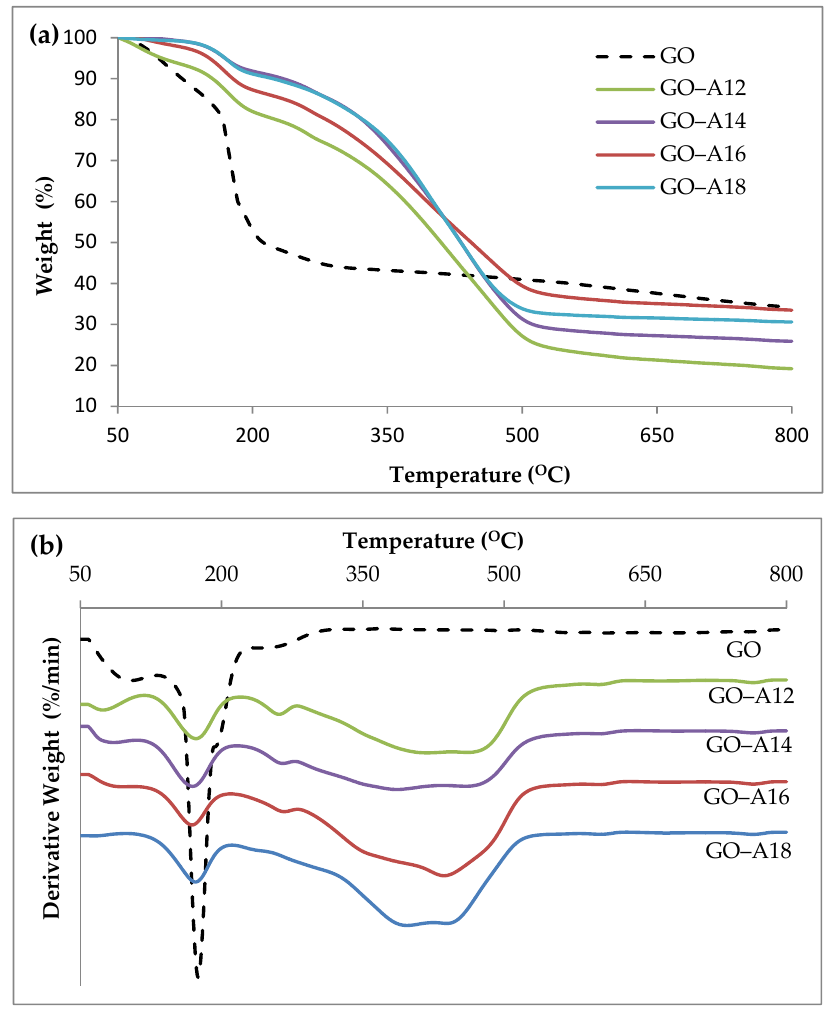
Figure 3. ( a ) TG; and ( b ) DTG thermograms of GO and functionalized GO.